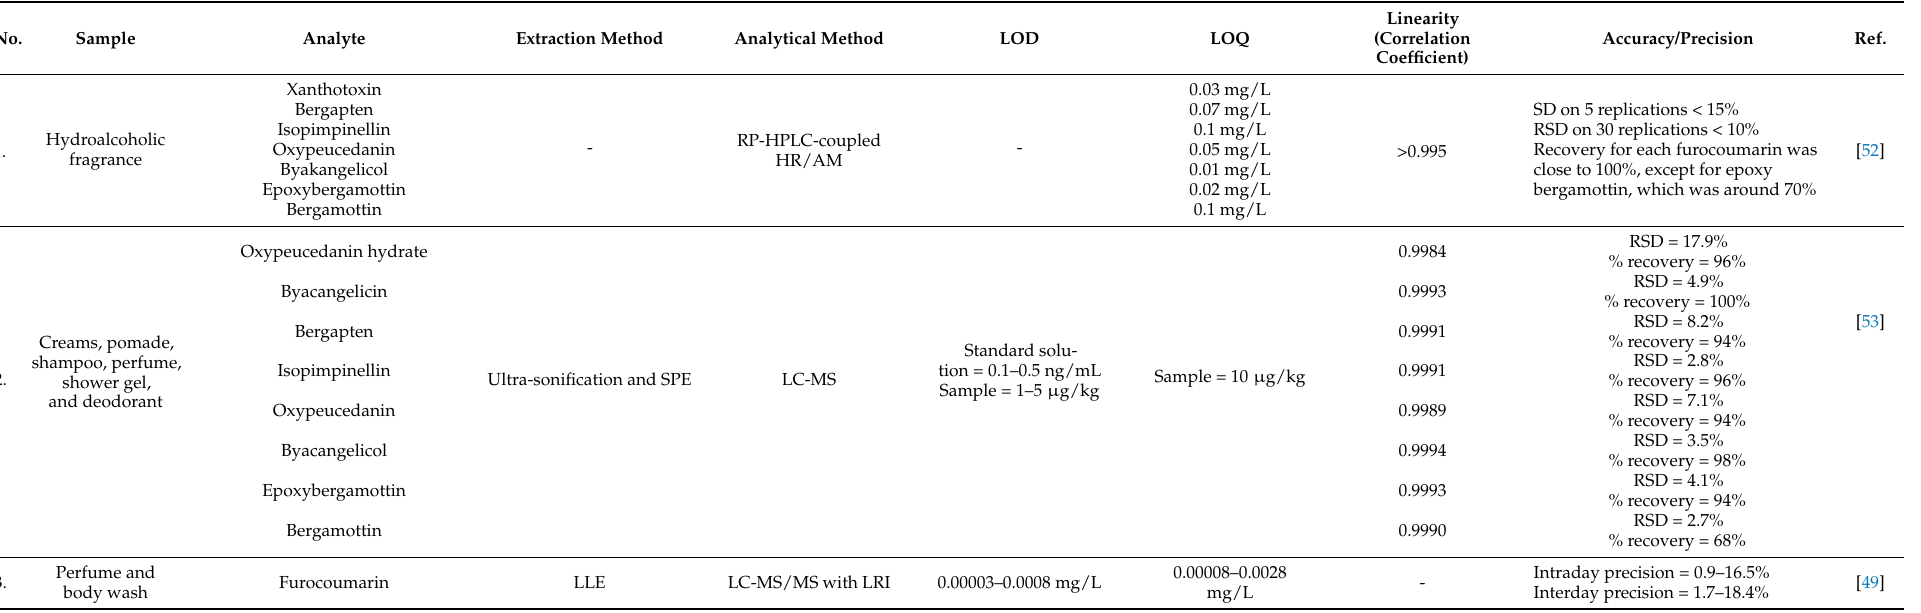
Table 9. Analytical method for determining furocoumarin in